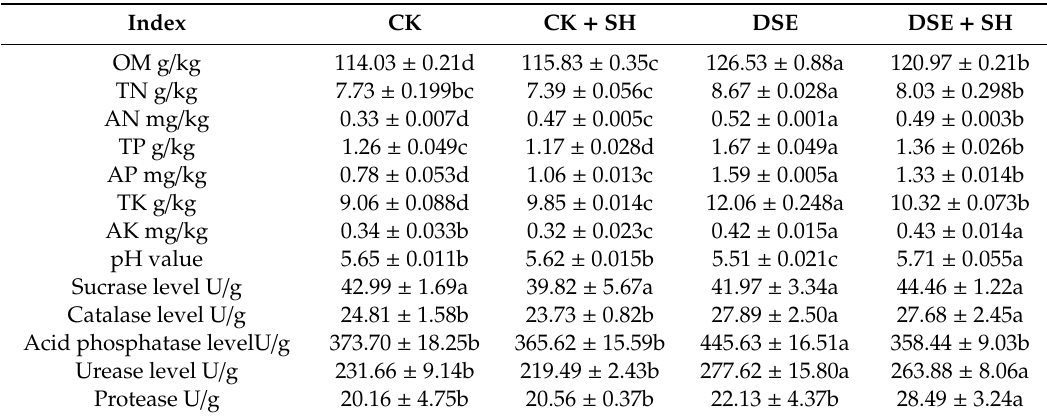
Table 3. Di ff erent inoculation treatment impacts on the enzyme activities and nutrients in